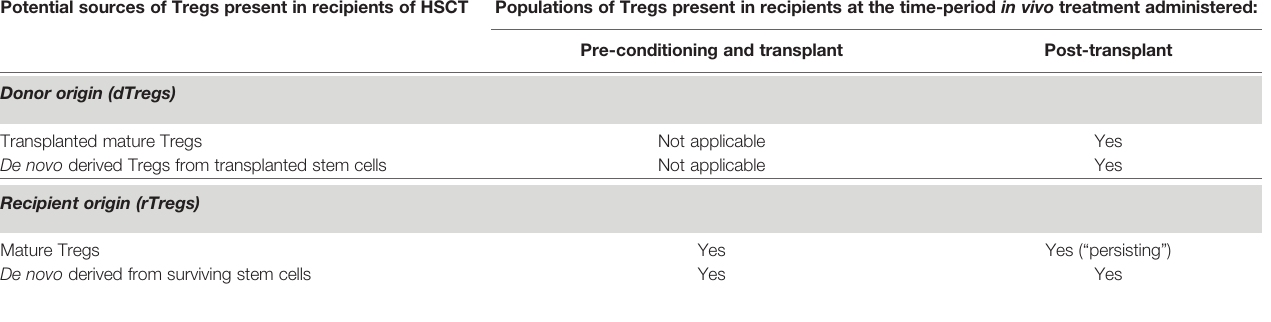
TABLE 1 | Sources of Tregs in recipients before and after hematopoietic stem cell transplants. Potential sources of Tregs present in recipients of HSCT Populations of Tregs present in recipients at the time-period in vivo treatment administered: Pre-conditioning and